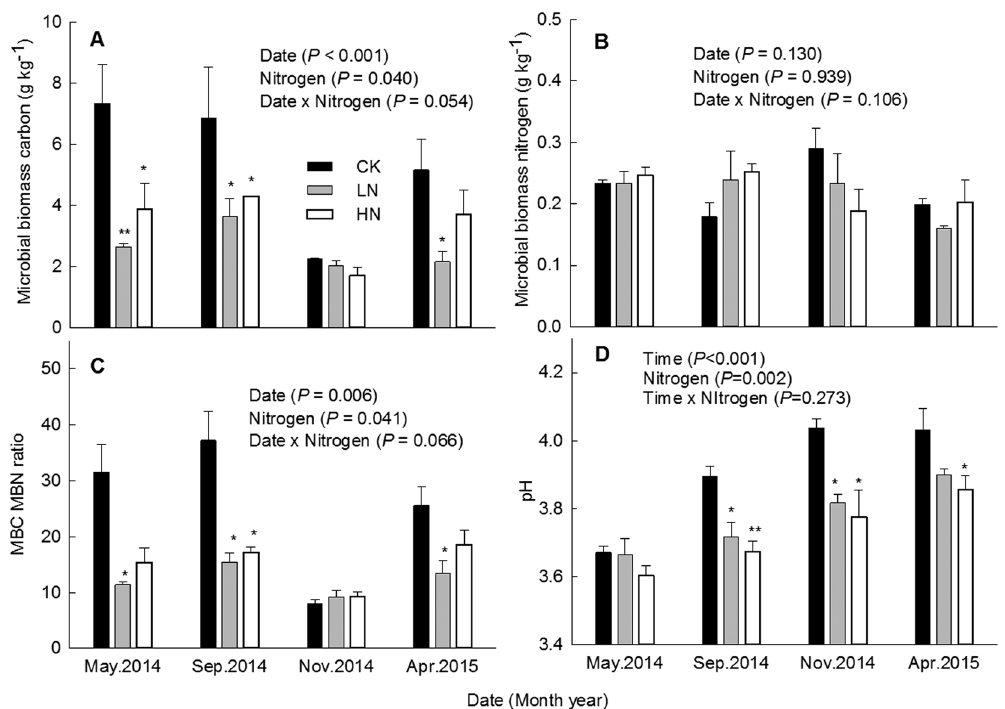
Figure 3. Soil microbial properties and pH values under different nitrogen treatments in a secondary evergreen broad-leaved forest ecosystem, southwestern China. Values are means ± 1 SE. Error bars indicate ± 1 SE, N = 3. The results of repeated measures ANOVAs are shown for each parameter. Asterisk ( * ) indicate a significant difference between the control and experimental N treatment at P < 0.05; double asterisks ( ** ) indicate a significant difference between the control and experimental N treatment at P <